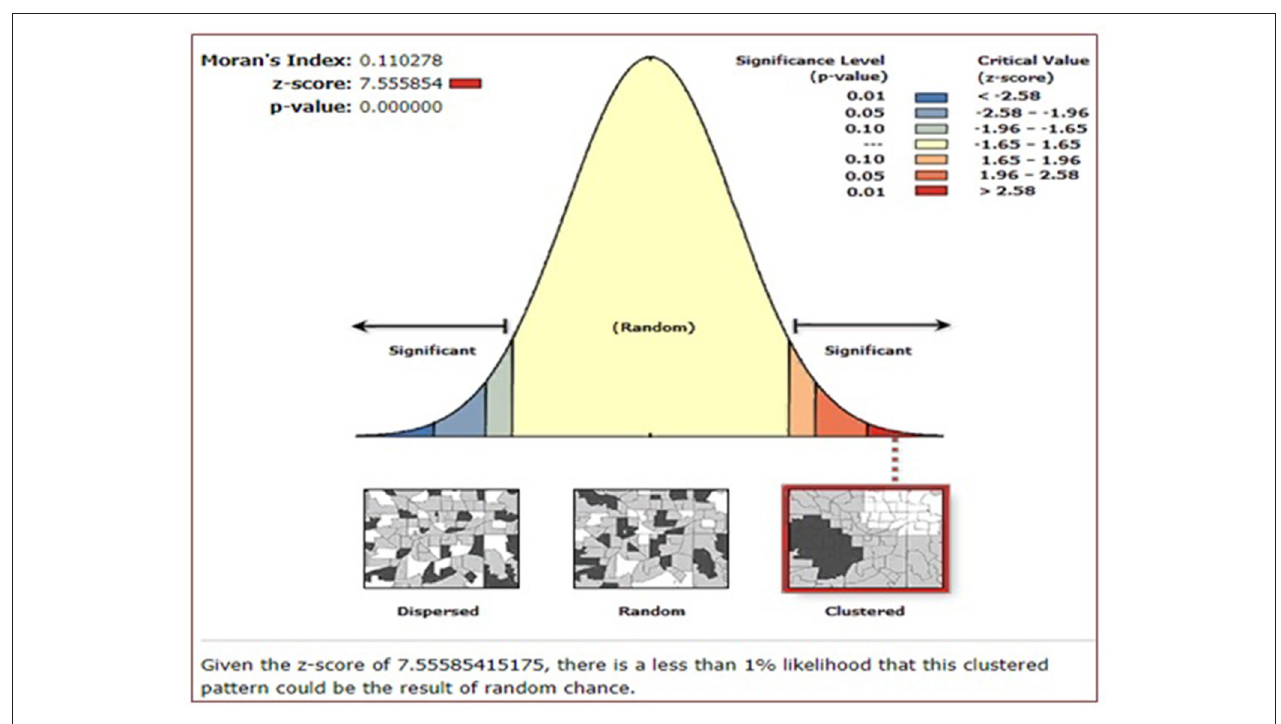
FIGURE 2 | Spatial autocorrelation of resumption of postpartum menses among women in Ethiopia, Ethiopian Demographic and Health Survey (EDHS)